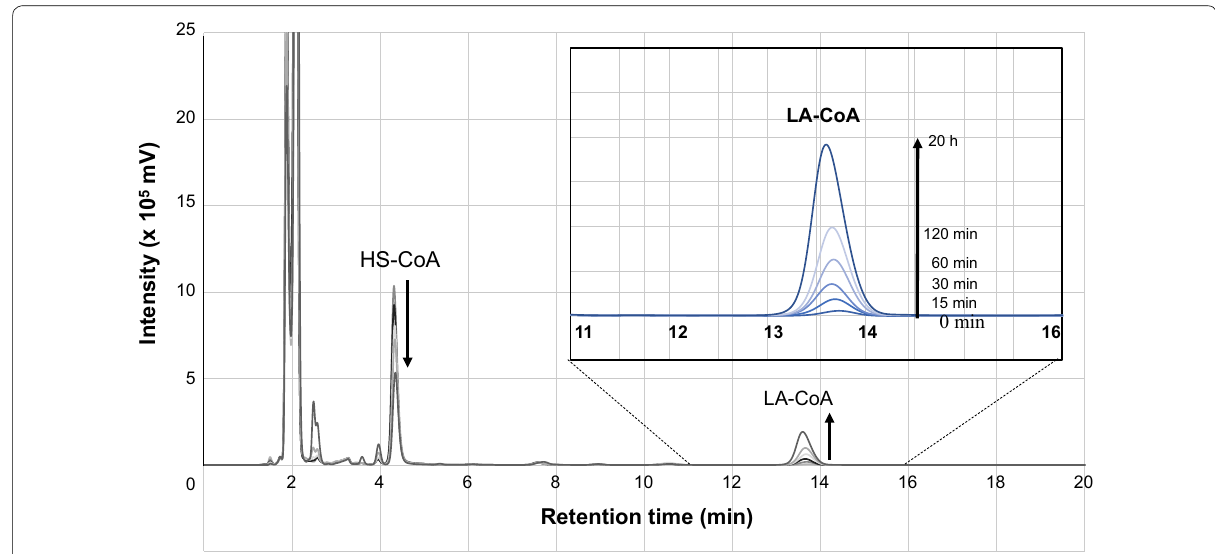
Fig. 3 Formation of levulinyl-CoA (LA-CoA) from sodium levulinate, HS-CoA, and ATP in extracts of E . coli JM109 carrying the lvaE2 gene (pCo7-387CoA-L) at 30 °C. HPLC analyses were performed using samples of the reaction mixture taken at 0, 15, 30, 60, and 120 min and 20 h after the addition of approximately 300 μL of crude cell extract (0.4 μg mL − 1 ) into a total of 1500 mL reaction mixture. Up and down arrows indicate increasing and decreasing contents of LA-CoA and HS-CoA, respectively. Retention times of authentic HS-CoA and LA-CoA peaks were 4.3 min and 13.6 min,